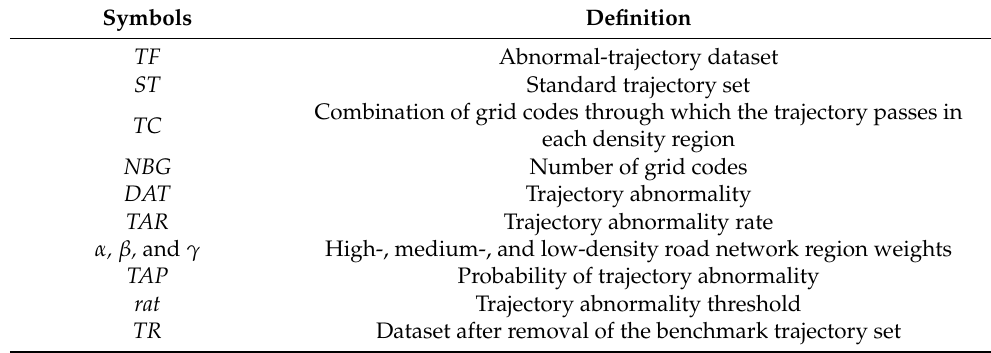
Table 1. Symbols used in the algorithm.